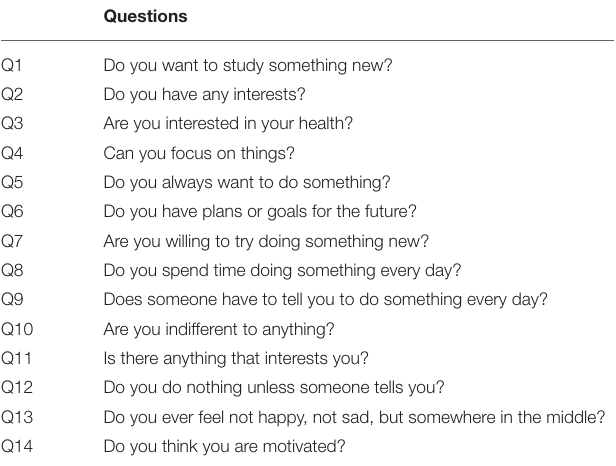
TABLE 1 | Questionnaire items.